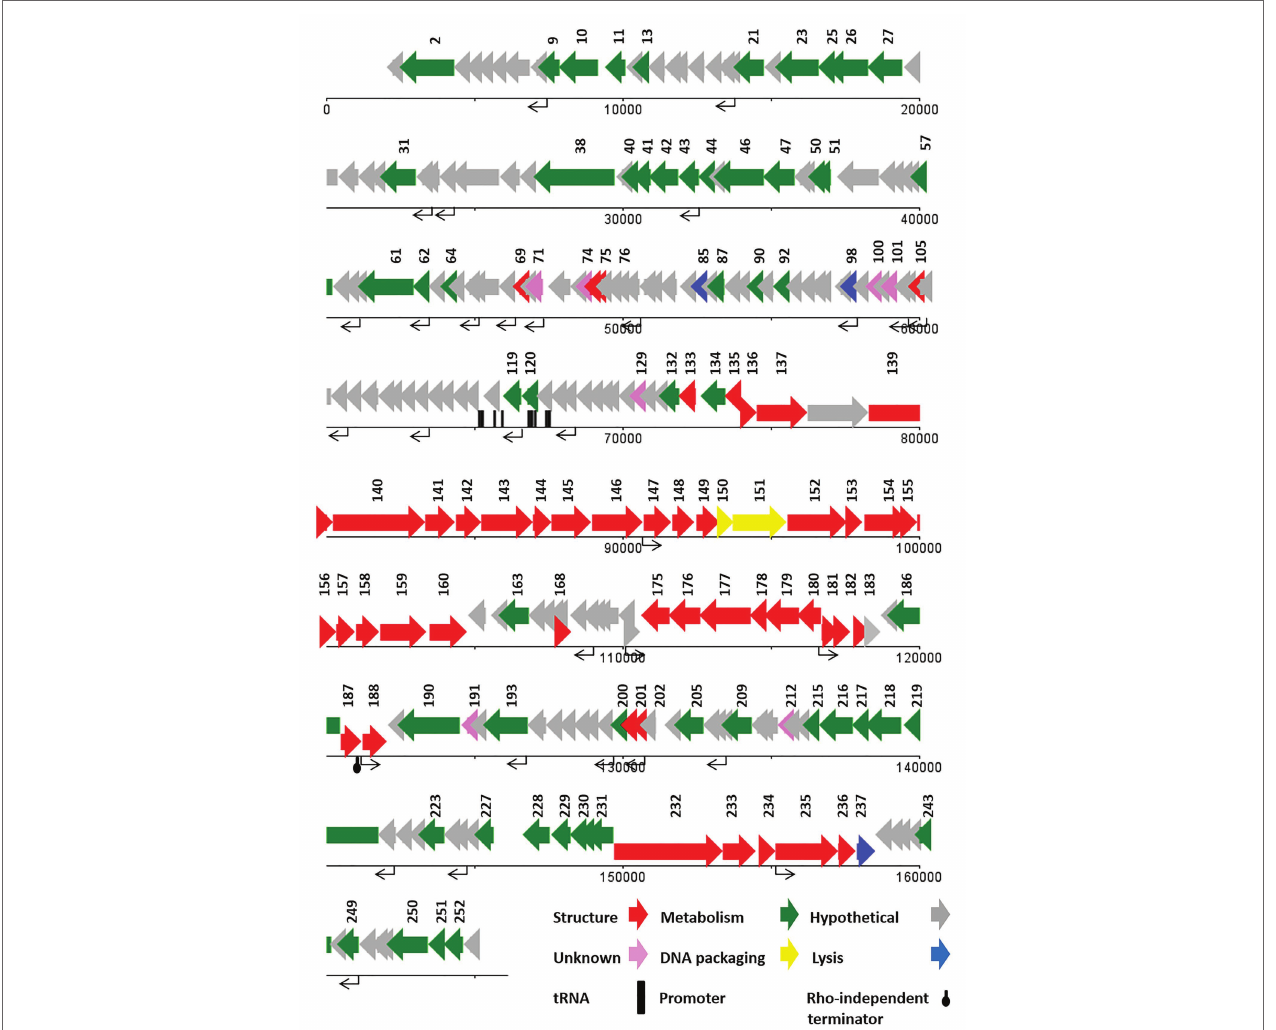
FIGURE 5 | The linear genome map of phage